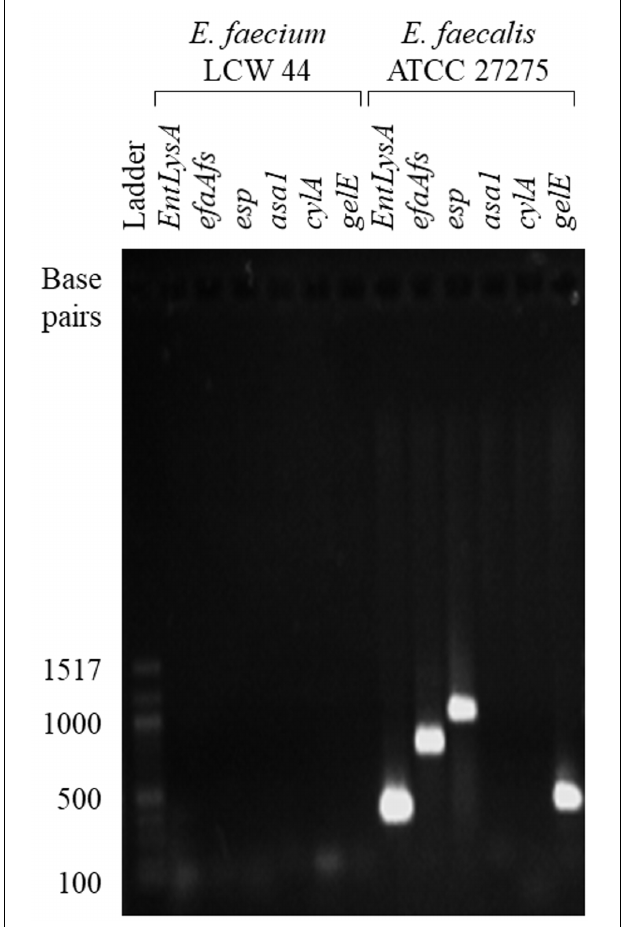
FIGURE 2 | PCR fragments generated from total genome of E. faecium LCW 44 and E. faecalis ATCC 27275 using oligonucleotide primers specific for enterolysin A ( EntLysA ), cell wall adhesin ( efaAfs ), surface protein involved in immune evasion ( esp ), aggregation substance ( asa1 ), cytolysin ( cylA ) and gelatinase ( gelE ), resolved by electrophoresis on agarose